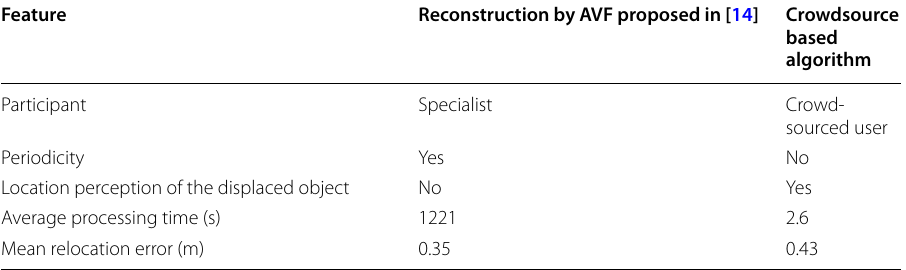
based algorithm sourced user